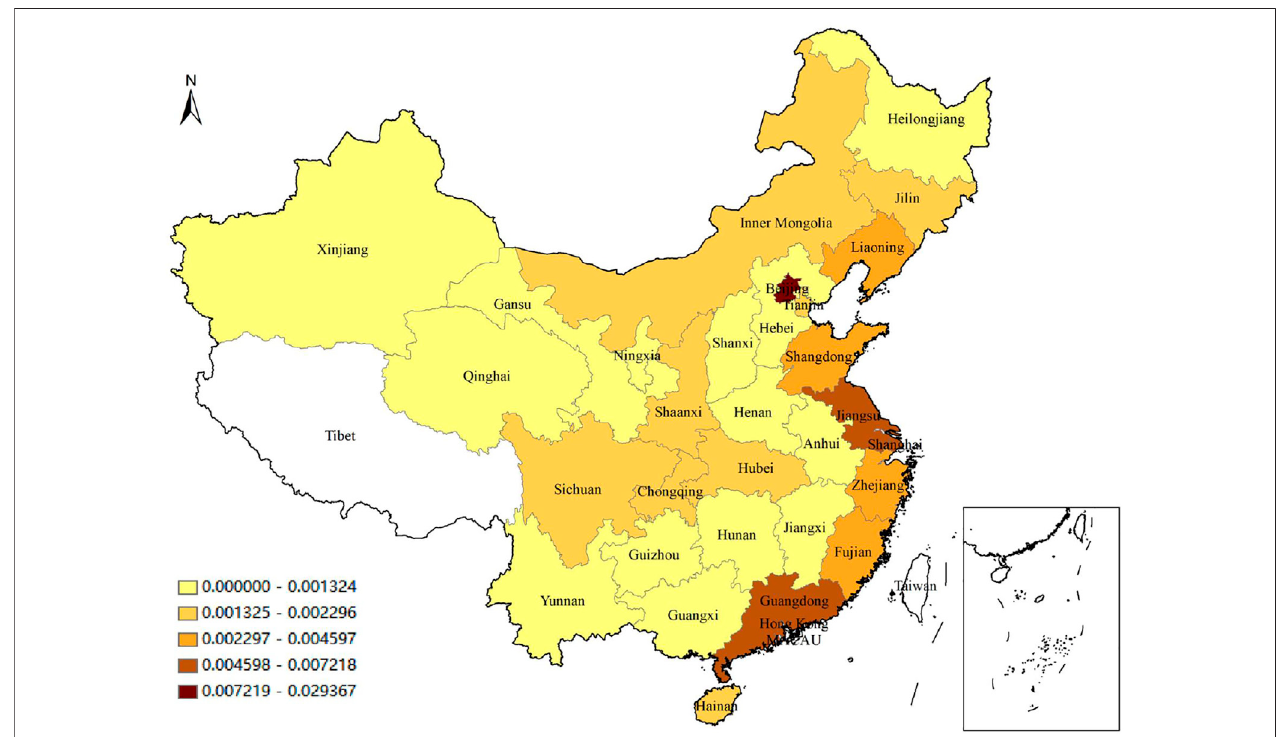
FIGURE 3 | Distribution map of digital economy index in